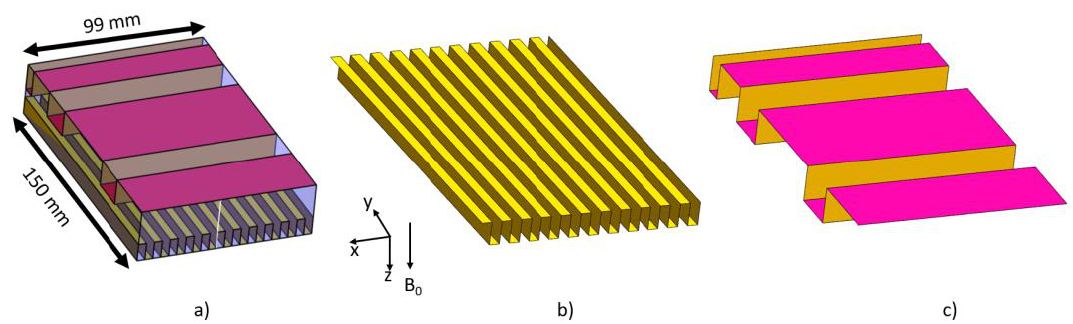
Figure 3. ( a ) The reduced patch antenna in the vertical and horizontal directions, ( b ) the ground plane meandering pattern and ( c ) the patch ( top ) plane meandering pattern.